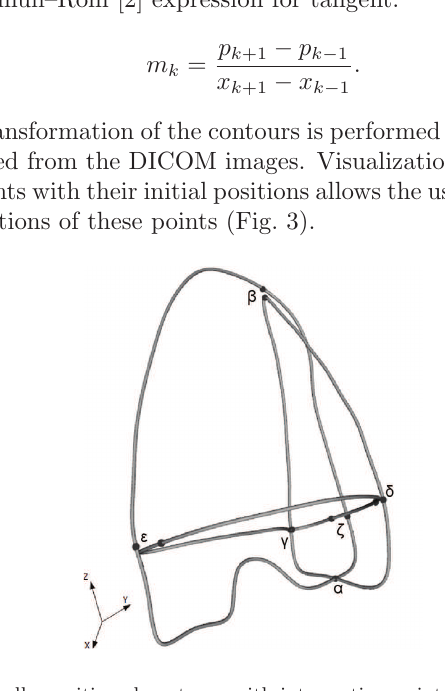
Figure 3. Manually positioned contours with intersection points and labels. Intersection points will be merged in the next processing step. We note that every pair of the contours has intersection points that do not necessarily coincide. These points are then connected by slight deformation of the contours. Then, final positioning of the contours and points places the contour of the lateral plane in parallel to xOy plane, the contour of the four- chamber plane in parallel to yOz plane, and the contour of the transverse plane in parallel to xOz plane. Thus, all contours are orthogonal to each other. All this operations are performed using a affine transformations of R 3